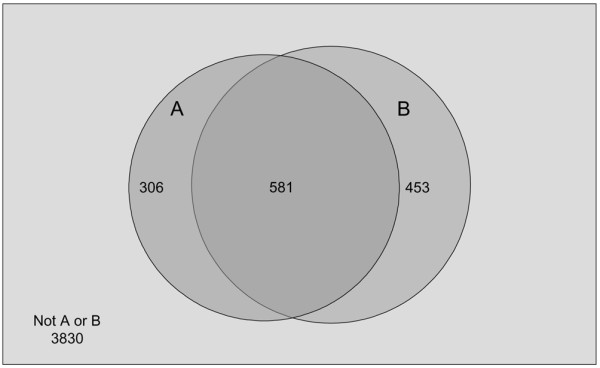
Venn diagram of patient groups. More patients met criteria for late anemia (group B, n = 1,034) than for late transfusion (group A, n = 887). More than one-quarter (1,340/5,170; 25.9%) of all patients admitted to the intensive care unit met criteria for at least one group. Although there is considerable overlap, a significant proportion of patients (759/5,170; 14.7%) met only one set of criteria.